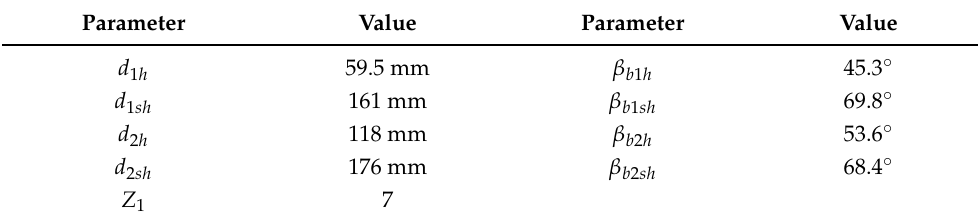
Table 1. Upstream-impeller geometric